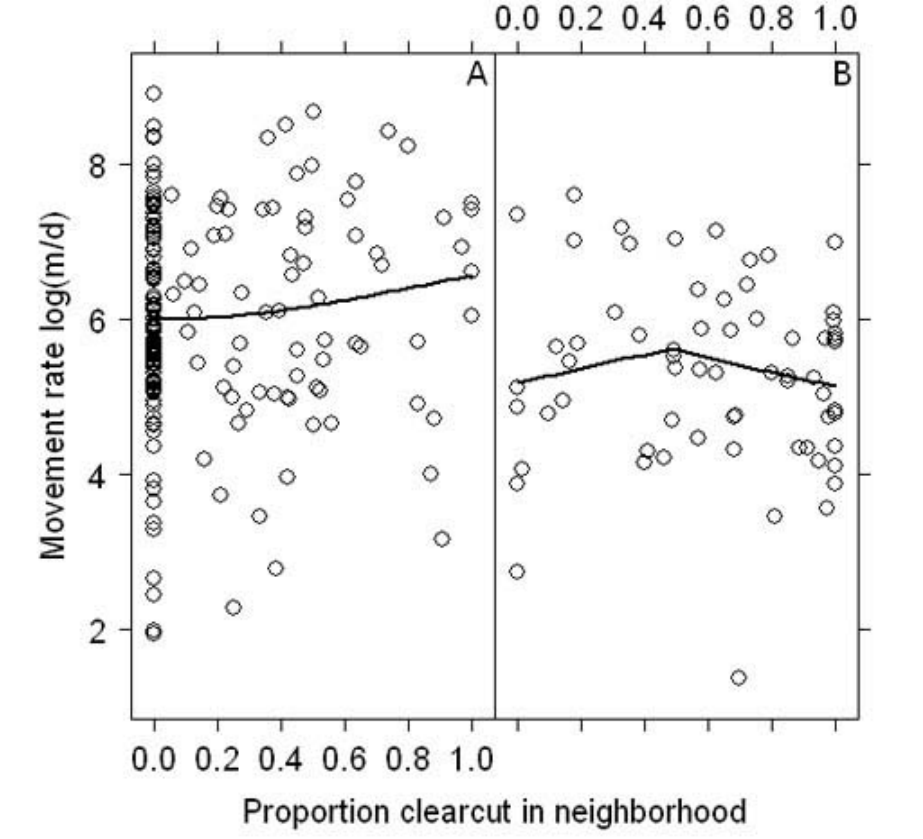
Fig. 7. Scatter-plot illustrating movement rate interaction between the proportion of clearcut land cover at the neighborhood scale and the proportion of clearcut land cover along an individual’s movement path for Blackpoll Warblers. (A) 0 – 35% of buffer surrounding movement path composed of clearcut land cover. (B) 35 – 70% of buffer surrounding movement path composed of clearcut land cover. Trends illustrated with locally weighted regression